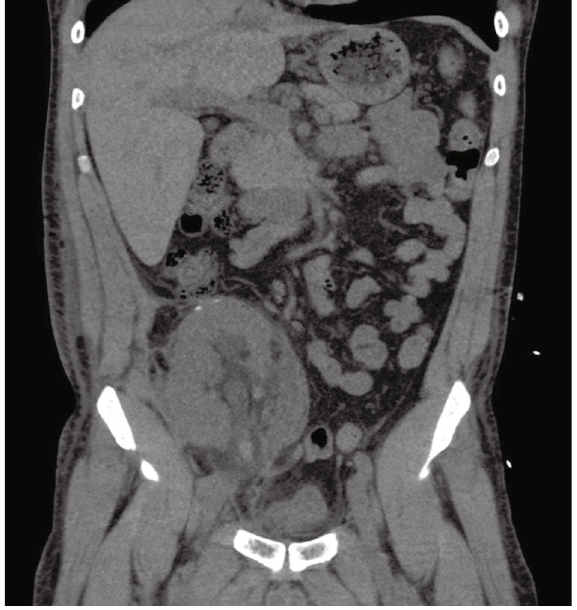
Figure 1: Coronal view of the CT scan showing hydronephrosis and clot in the transplanted ureter.